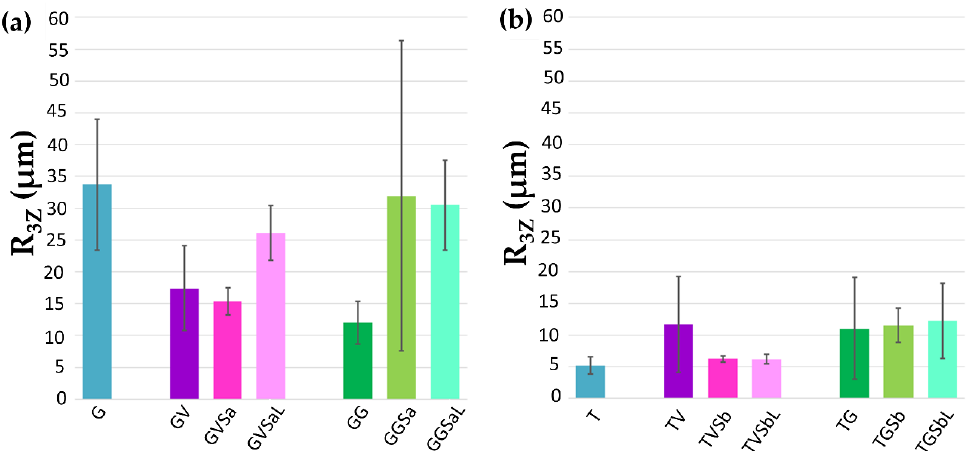
Figure 7. R 3z ( µ m) of the reference stones (G: gneiss; T: travertine), the painted surfaces (GV: gneiss with violet paint; GG: gneiss with green paint; TV: travertine with violet paint; TG: travertine with green paint) and the surfaces treated with the di ff erent cleaning methods: respectively, the use of solvent mixtures and a combined methodology, based on the chemical cleaning followed by the laser. ( a ) Gneiss samples. ( b ) Travertine samples. Standard deviation values are also shown. Check Table 3 for sample labels.